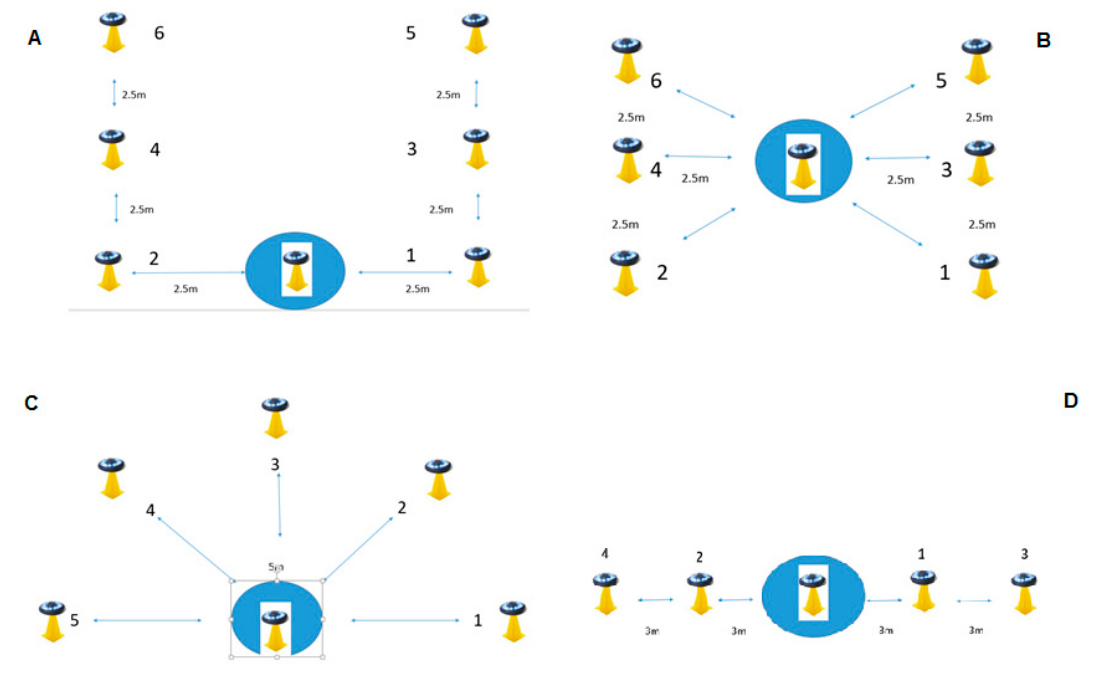
Figure 1. Arrangement of FitLight Trainer lights in the frontal ( A ), universal ( B ), semi-circular ( C ), and lateral ( D ) spatial configurations.